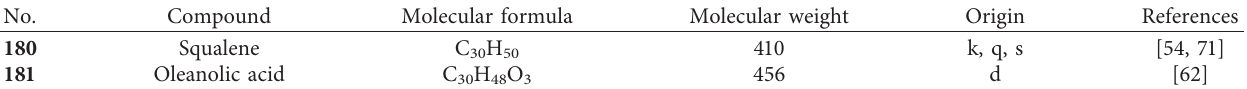
Table 4: Triterpenes from the genus Cinnamomum . tblBody